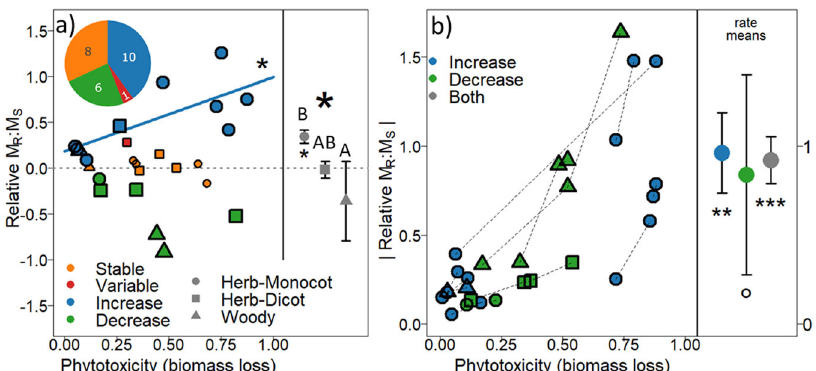
Fig. 3 Results of the meta-analysis of published results regarding biomass partitioning on polluted soils. a Effect size on M R :M S in regards of phytotoxicity (normalised biomass loss) for the different case studies. For each case study, the response on all polluted soils were averaged before calculating a single value for the relative M R :M S and phytotoxicity. The classi fi cation of the M R :M S response is shown: stable (orange); variable (red); increase (blue); and decrease (green). The number of case studies found for each class is shown in the top left pie chart. Different plant functional groups are distinguished with different symbols. The amplitude of changes in M R :M S is related to the amplitude of phytotoxicity for case studies corresponding to the “ increase ” class (* P < 0.05). On the right-hand side of the panel, mean (±se) of relative M R :M S are shown for the three plant functional groups. The functional group has a signi fi cant effect on relative M R :M S (ANOVA, * P < 0.05). Different letters indicate a signi fi cant difference between groups ( P < 0.05 after post-hoc pairwise multiple comparisons). Wilcoxon tests were performed for each group to test difference from zero (* P < 0.05). See Supplementary Table 3 for corresponding degrees of freedom and associated p -values. b Effect size on M R :M S regarding phytotoxicity within each case study having at least two different polluted soils and showing an increase or decrease of M R :M s . Note that relative M R :M S are shown in absolute values. Responses from the same case study are linked with dotted lines. Symbols (circle, square, and triangle) are as in ( a ). The rate of change ( Δ M R : M S / Δ biomass loss) is calculated for each case study. Mean rates and their con fi dence intervals (CI 95% ) are shown. Wilcoxon tests (*** P < 0.001; ** P < 0.01; ° P < 0.1) were used to test the difference of rate means from